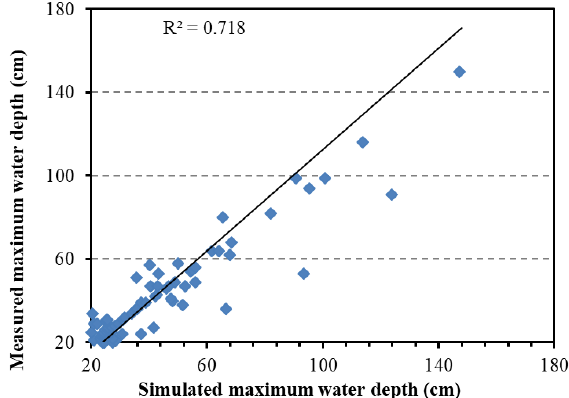
Figure 6. Simulation error chart of waterlogging at selected 42 waterlogging